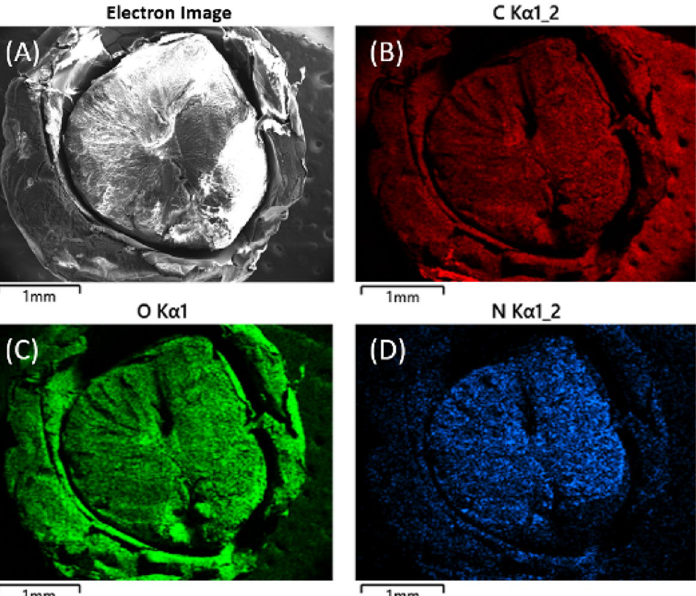
Figure 3. FE-SEM images of cellulose-coated CS bead ( A ) and EDS mapping of C ( B ), O ( C ), N ( D ) elements.